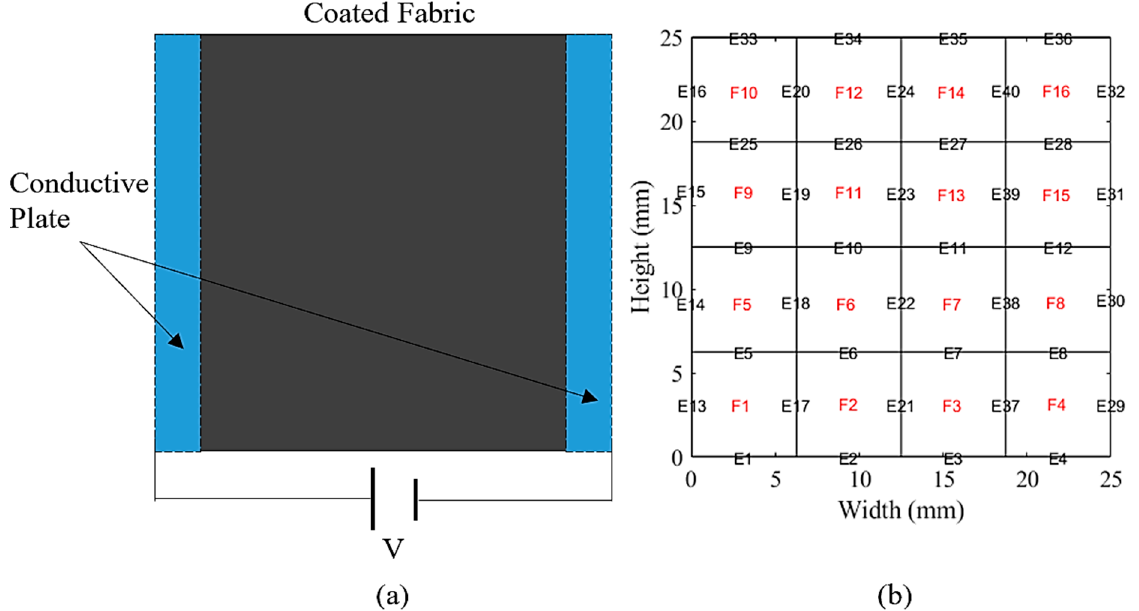
Figure 2. ( a ) Schematic representation of the heating fabric, and ( b ) the equivalent finite element model boundary conditions. Table 1. Model parameters.